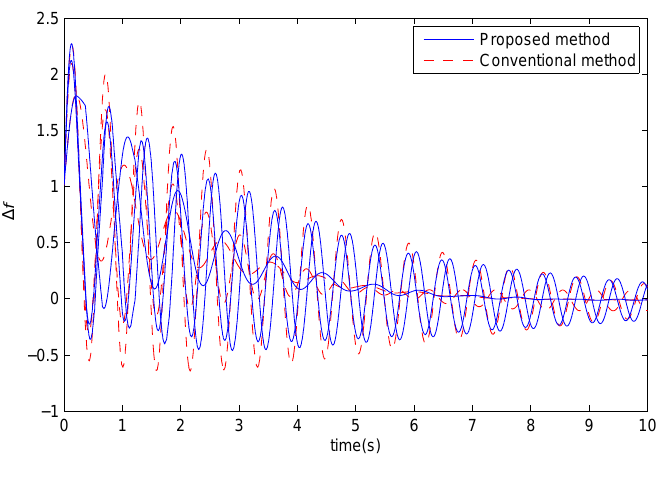
Figure 8. The frequency deviation ∆ f .